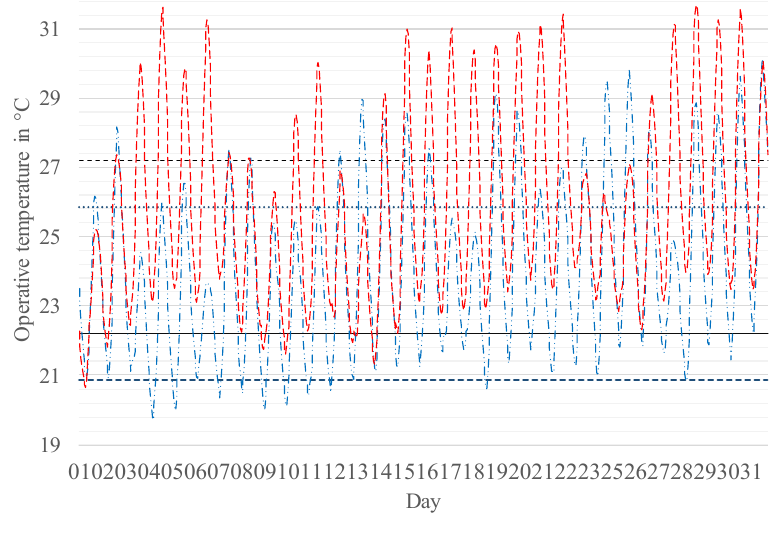
Fig. 12. Selective algorithm, Season A.